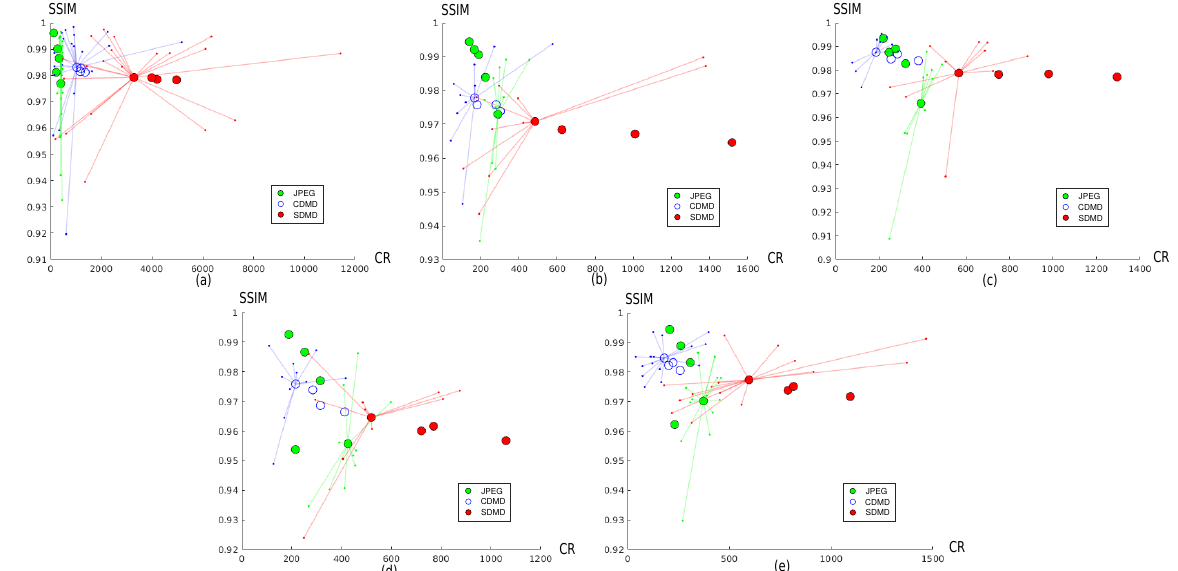
Figure 11. Comparison of CDMD (blue dots), JPEG (green dots), and SDMD (red dots) for graphics art images ( a ), cartoon images ( b ), computer graphics ( c ), medical images ( d ), and SciVis data ( e ). The actual image data (smaller dots) are connected to the corresponding average value (larger dots) for one parameter setting of each